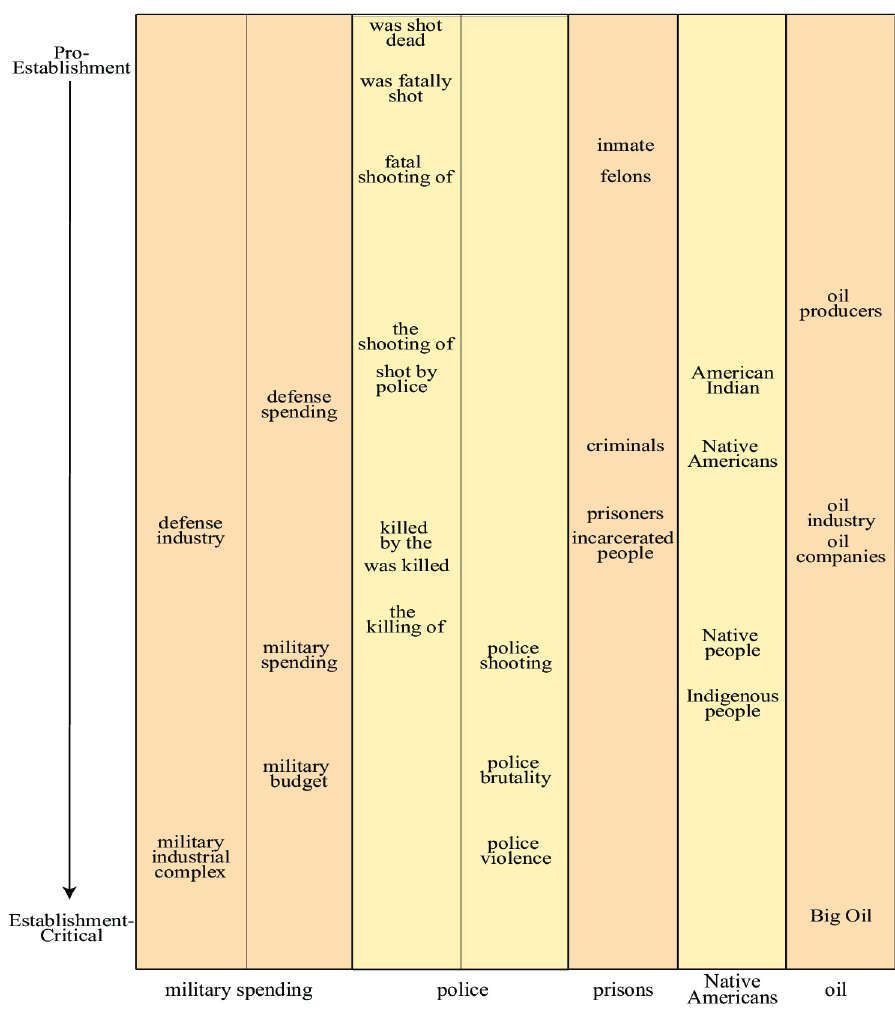
Fig 11. Valent synonyms reflecting establishment